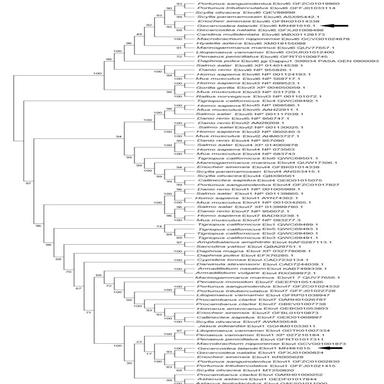
Maximum Likelihood phylogenetic analysis of the G. lalandii Elovl1 and Elovl6 sequences with 85 other elongase sequences from representative vertebrates and invertebrates using IQ-TREE ((http://www.iqtree.org/). Best tree was predicted using ModelFinder, the tree was built using LG + I + G4 as substitution model and tested with 1000 bootstrap value. The tree was drawn to scale, with branch lengths measured in the number of substitutions per site using Fig-Tree v1.4.4.